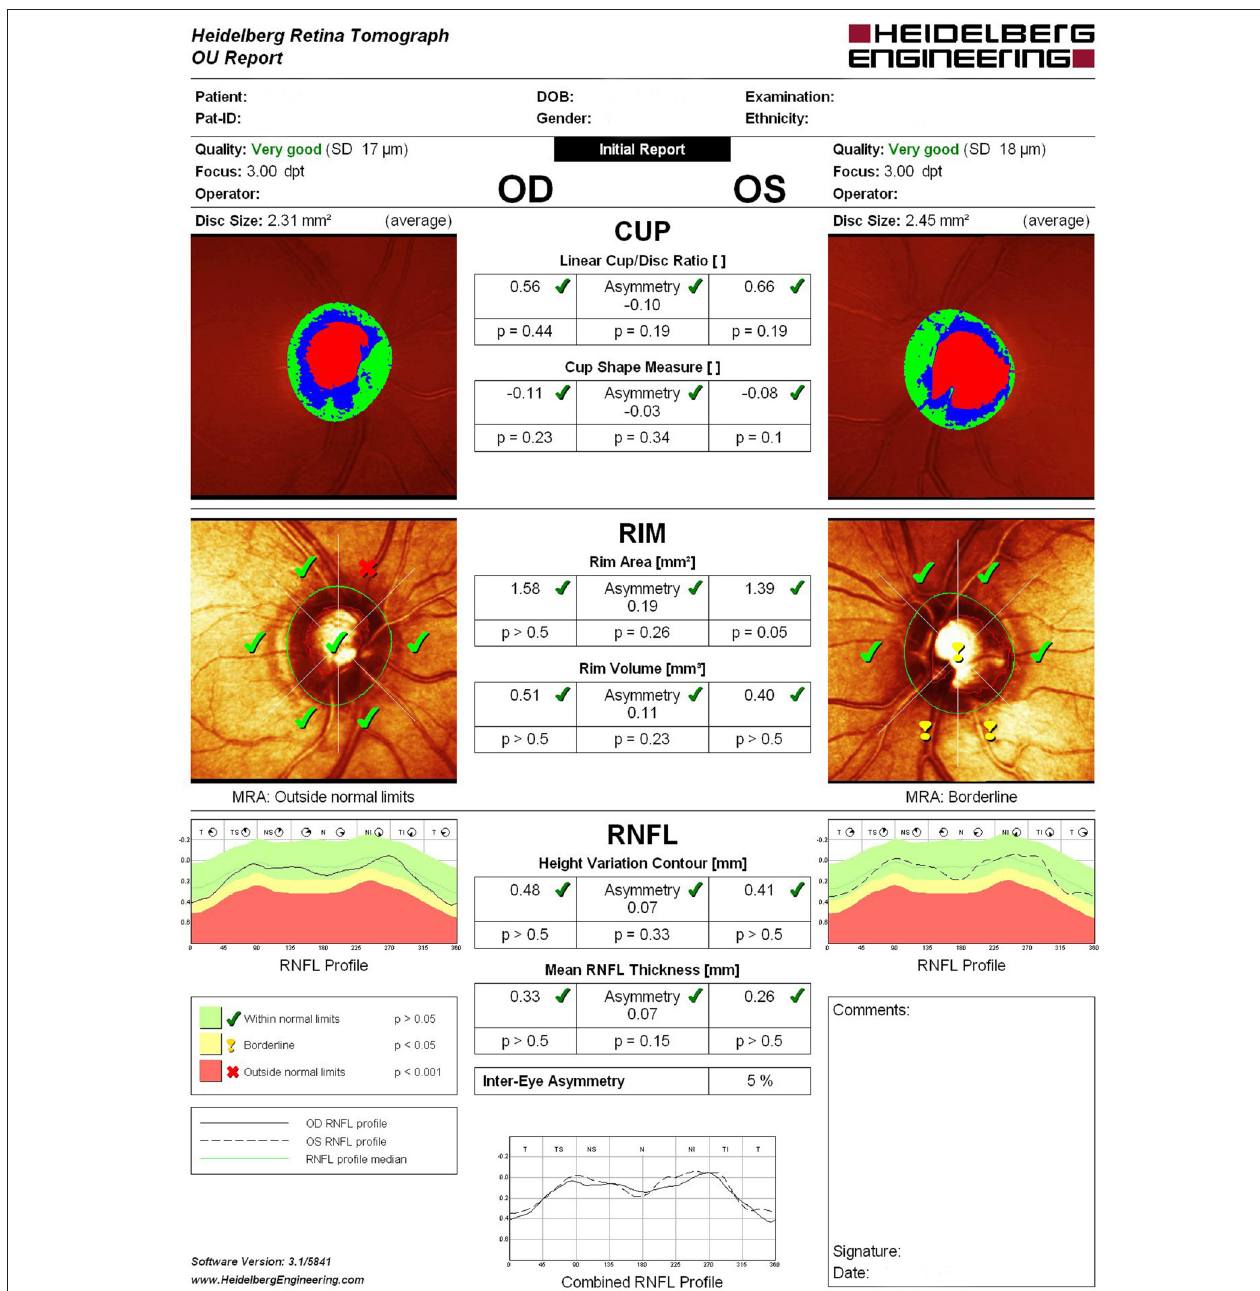
FIGURE 1 | Heidelberg retinal tomograph III (HRT-3) analisys report.